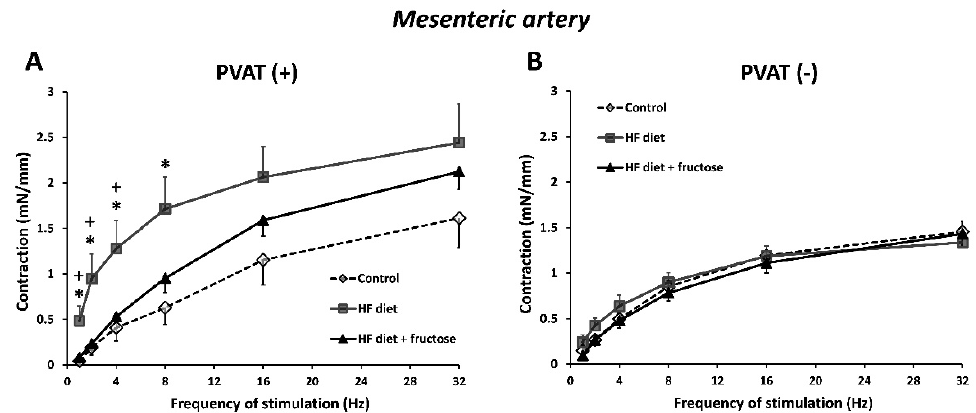
Figure 2. Frequency-dependent contractile responses to transmural electrical stimulation in PVAT(+) ( A ) and PVAT( − ) ( B ) preparations of mesenteric artery from Wistar–Kyoto rats: control, treated with high-fat (HF) diet, and treated with HF diet + fructose. * p < 0.05 vs. HF diet + fructose; + p < 0.05 vs. control. Values represent means ± SEM; n = 6.